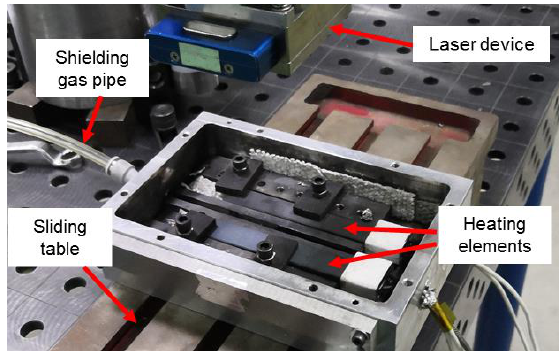
Figure 3. Experimental set-up for argon shielding and preheating.